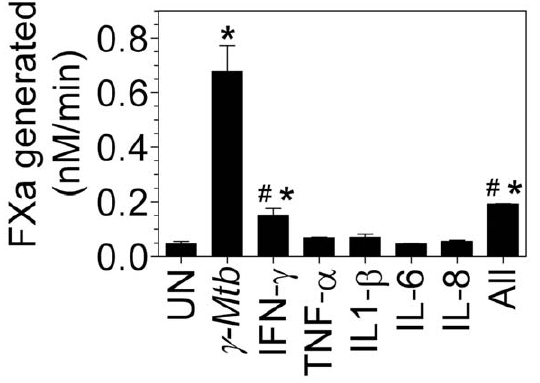
Figure 6. Effect of various cytokines, in comparison with c -Mtb , on induction of TF in macrophages. MDMs were treated with IFN- c (100 ng/ml), TNF- a (20 ng/ml), IL1- b (20 ng/ml), IL-6 (20 ng/ml) or IL-8 (20 ng/ml) for 9 h. In parallel, MDMs were treated with c - Mtb (10 m g/ ml). Cell surface TF activity was determined in factor X activation assay. * indicates significant difference compared to untreated control (P , 0.05); # denotes significant difference compared to c - Mtb treated cells (P , 0.05). Data are mean 6 SEM